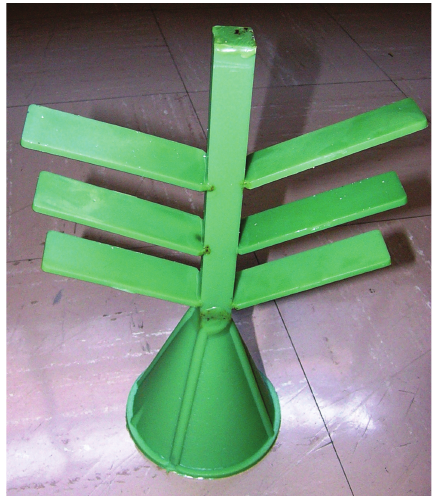
Figure 1: Wax pattern assembly used for IC of alloy